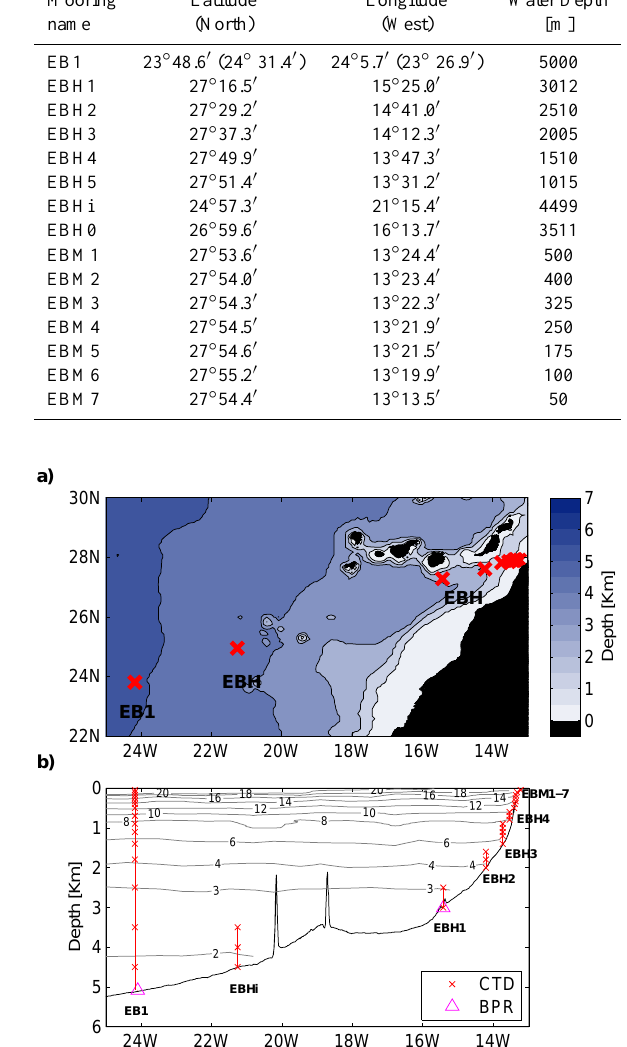
tween 565 dbar and 965 dbar, EBH4 between 1060 dbar to 1460 dbar, EBH3 between 1555 dbar and 1955 dbar, EBH2 at 2060 dbar and EBH1 between 2562 dbar and 2762